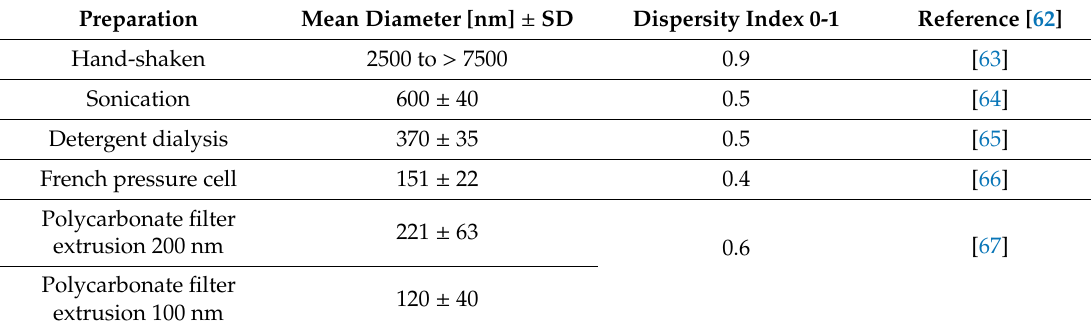
Table 7. Characteristics of MPL liposomes [55].